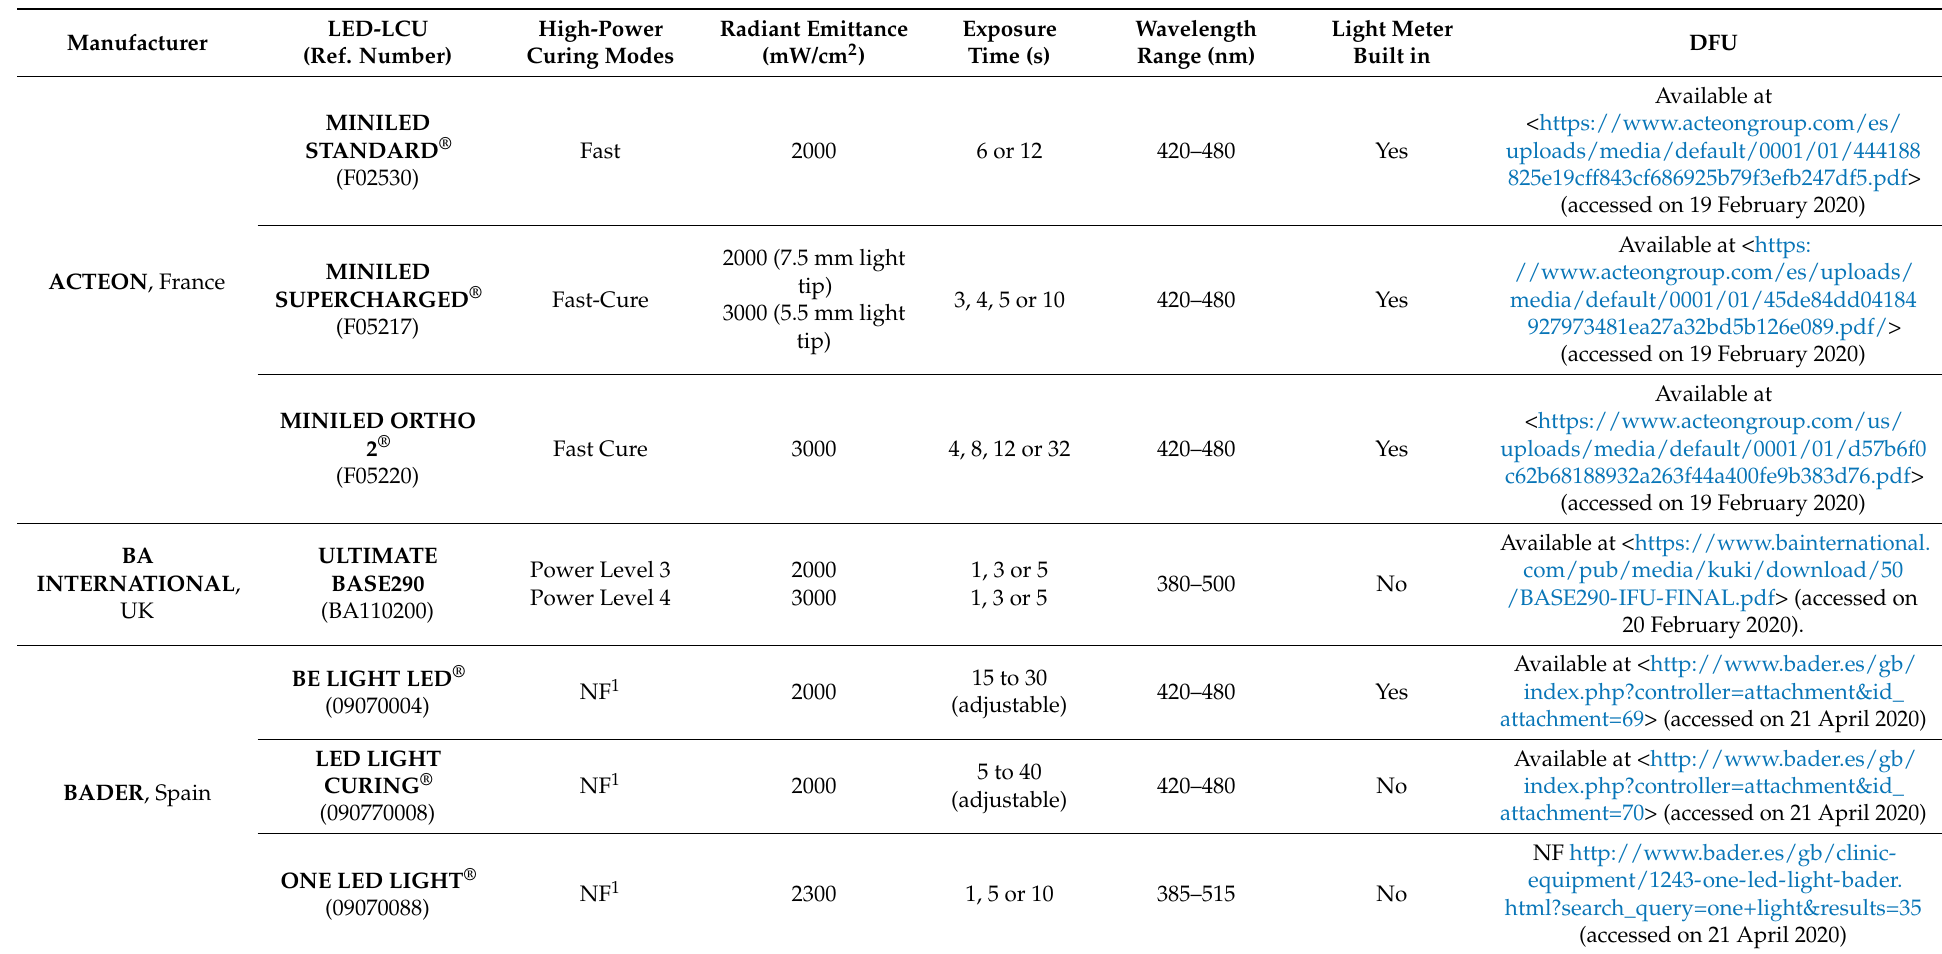
Table 7. High-power LED-LCUs commercially available and technical details: manufacturer, LED-LCU, radiant emittance and exposure time of high-power curing modes, estimated wavelength range, incorporated light meter, and directions for use